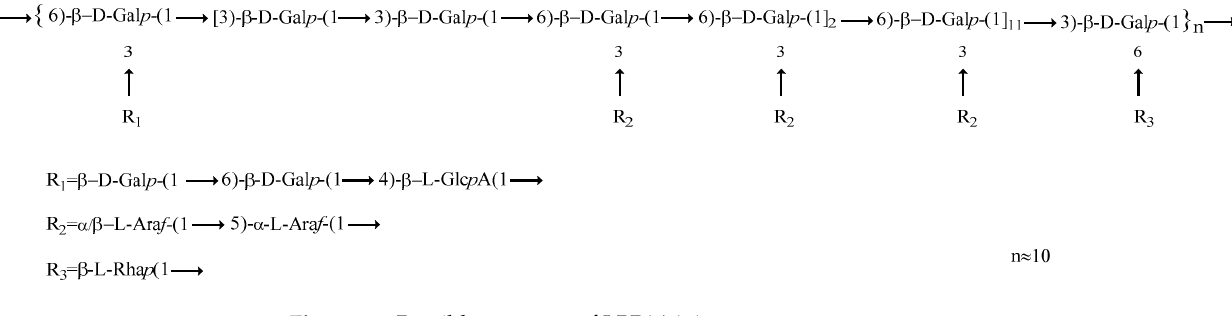
Figure 15. Possible structure of LBP1A1-1.